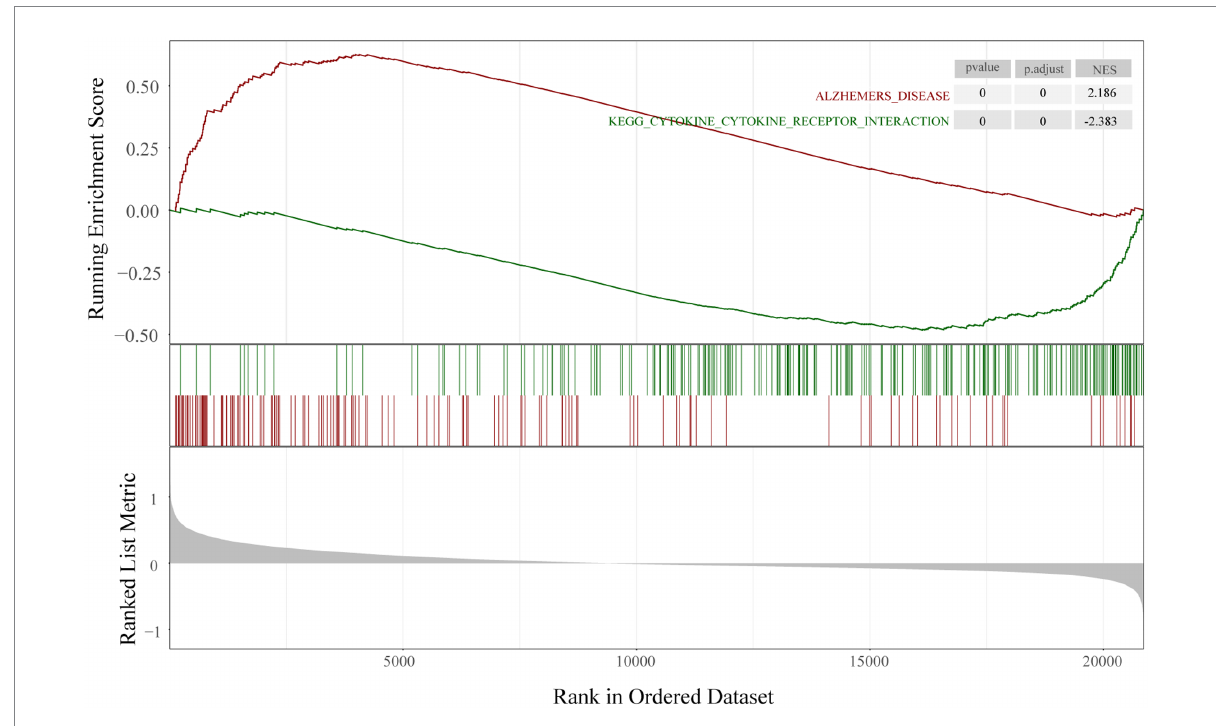
FIGURE 5 Gene set enrichment analysis. Running enrichment score was positive in Alzheimer’s disease and negative in KEGG cytokine-cytokine receptor interaction